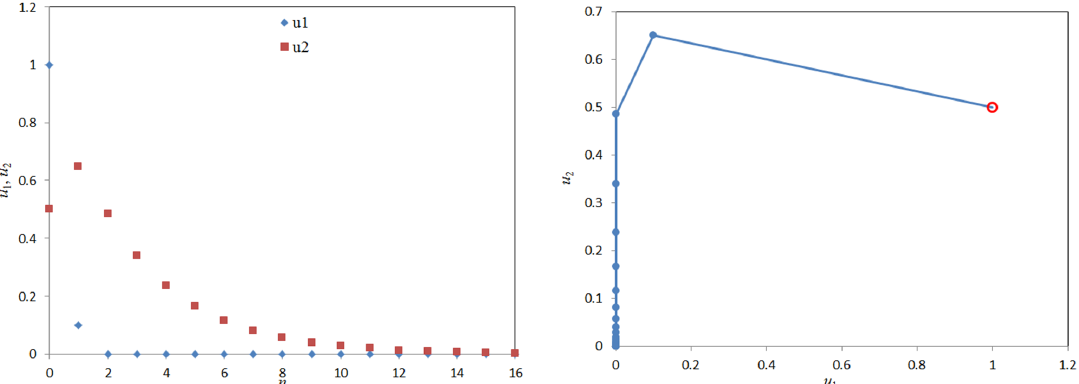
The discrepancy u 1 corresponds to the worker while the discrepancy u 2 corresponds to the employer. to the employer.